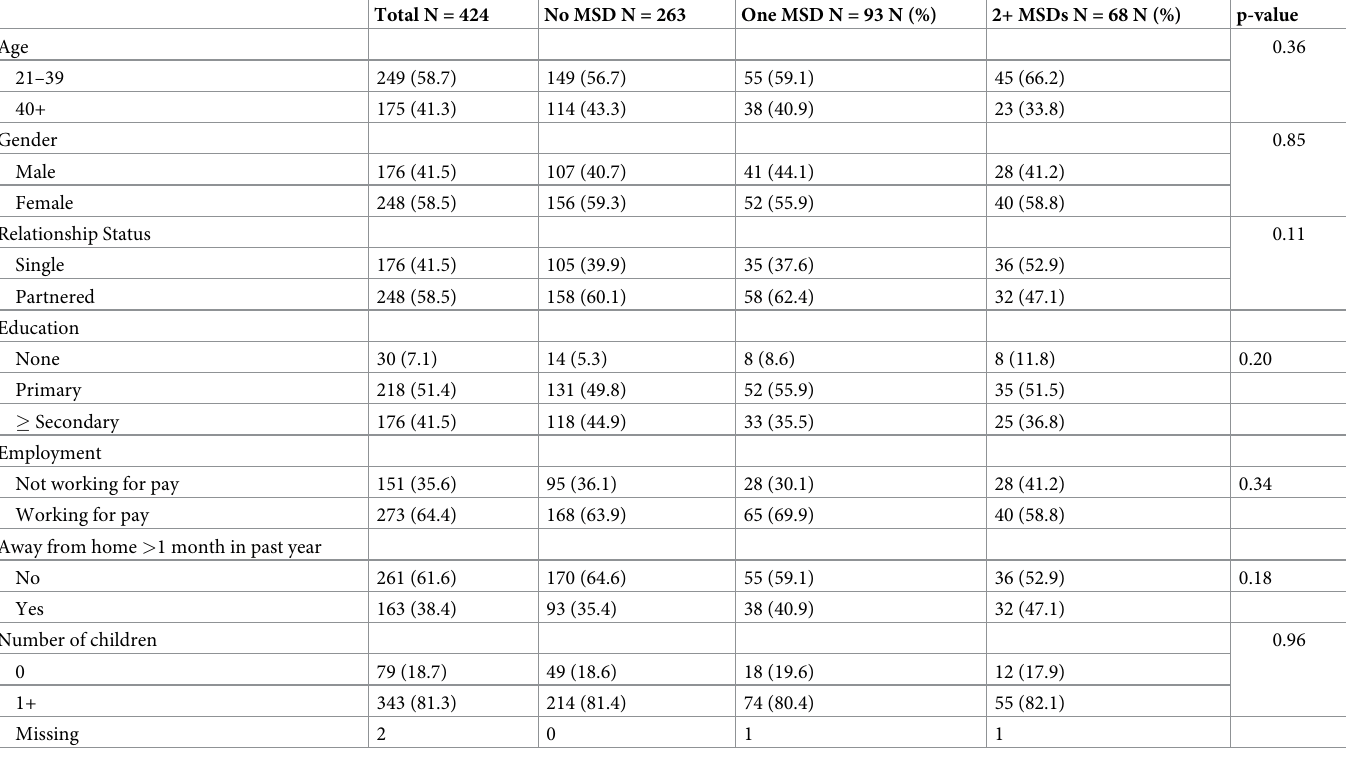
Table 1. Sociodemographics and psychiatric comorbidity among 424 PWH initiating HIV care in